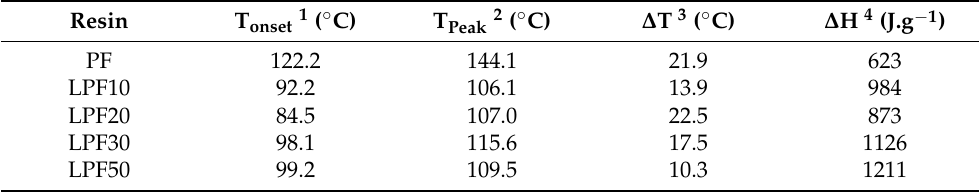
Figure 4. Diagrams of calorimetry analyses (heat flow per temperature) for different resins under study: ( a ) PF, ( b ) LPF10, ( c ) LPF20, ( d ) LPF30 and ( e ) LPF50. Table 3. Kinetics of thermal curing of resins by DSC.